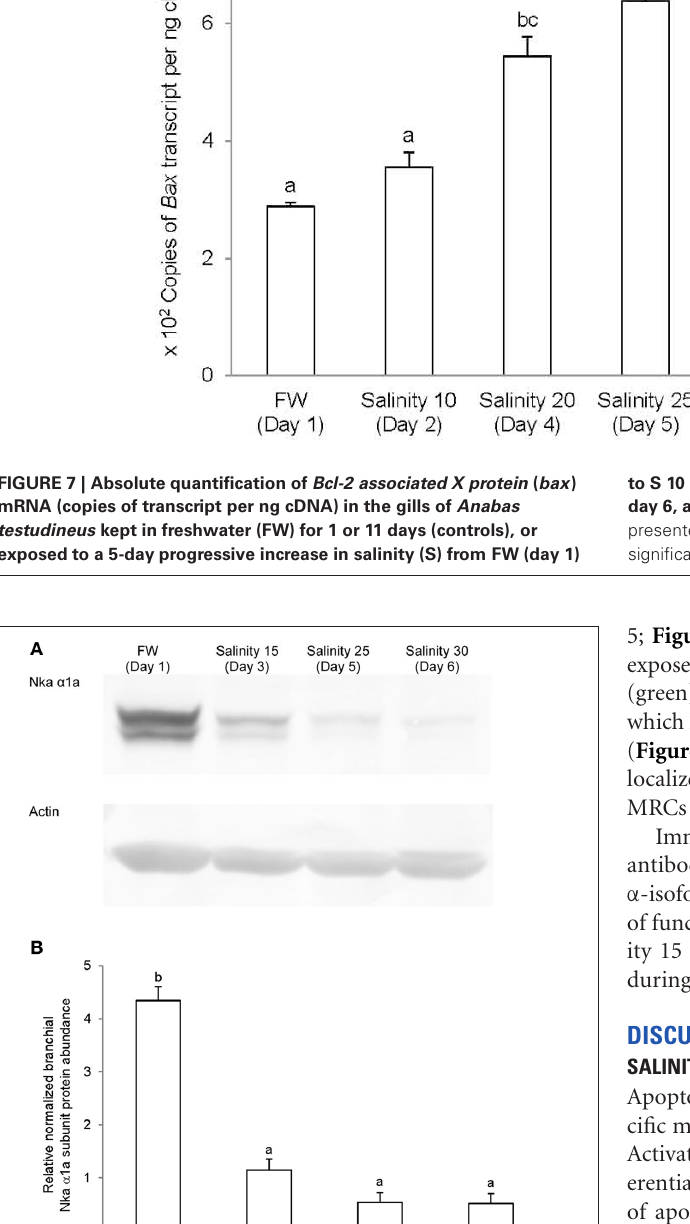
FIGURE 8 | Protein abundance of Na + /K + -ATPase α 1a (Nka α 1a) in the gills of Anabas testudineus kept in freshwater on day 1 (FW; control), or after 24h of exposure to salinity 15 on day 3, salinity 25 on day 5, or salinity 30 (seawater) on day 6 during a progressive acclimation from freshwater to seawater. (A) Immunoblots of Nka α 1a and actin. (B) The intensity of the Nka α 1a protein band normalized with respect to actin. Results represent mean + S.E.M. ( N = 4). Means not sharing the same letter are significantly different ( P < 0 . 05).